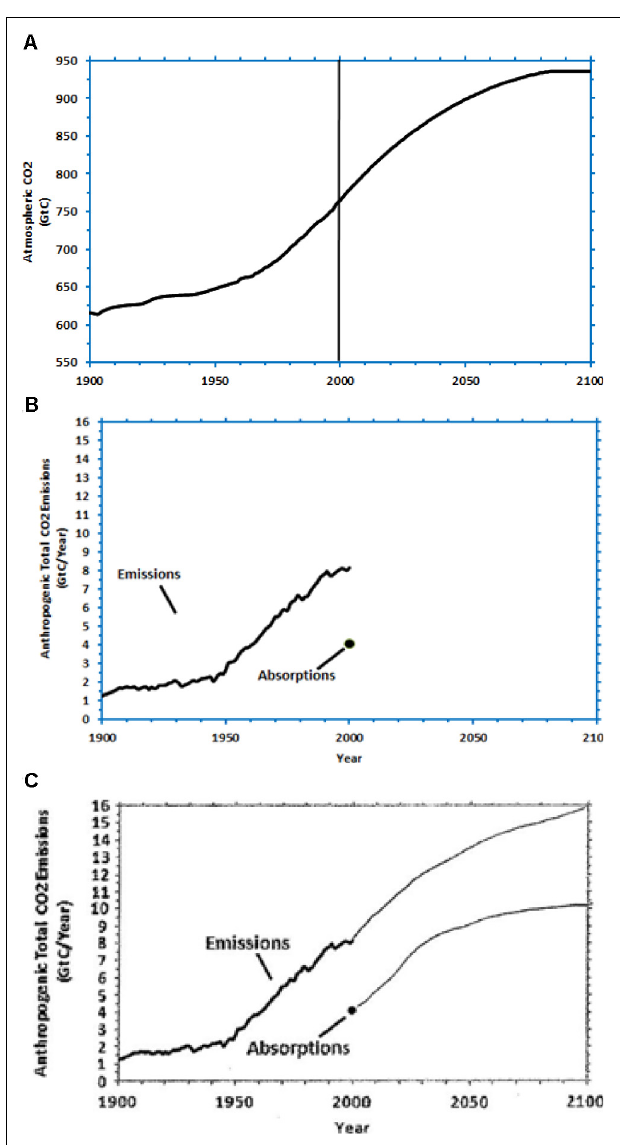
FIGURE 1 | The Climate Stabilization (CS) task. Participants are given CO 2 concentration stabilization scenario, and they are required to sketch the CO 2 emissions and absorptions corresponding to the scenario. (A) The problem presented shows increasing trajectory where CO 2 increases and stabilizes by 2100. (B) Values of emission and absorption between year 1900 and 2000. (C) A typical sketch by participants in the CS task relying on correlation heuristic and violation of mass balance for the increasing trajectory (Source: Dutt and Gonzalez,